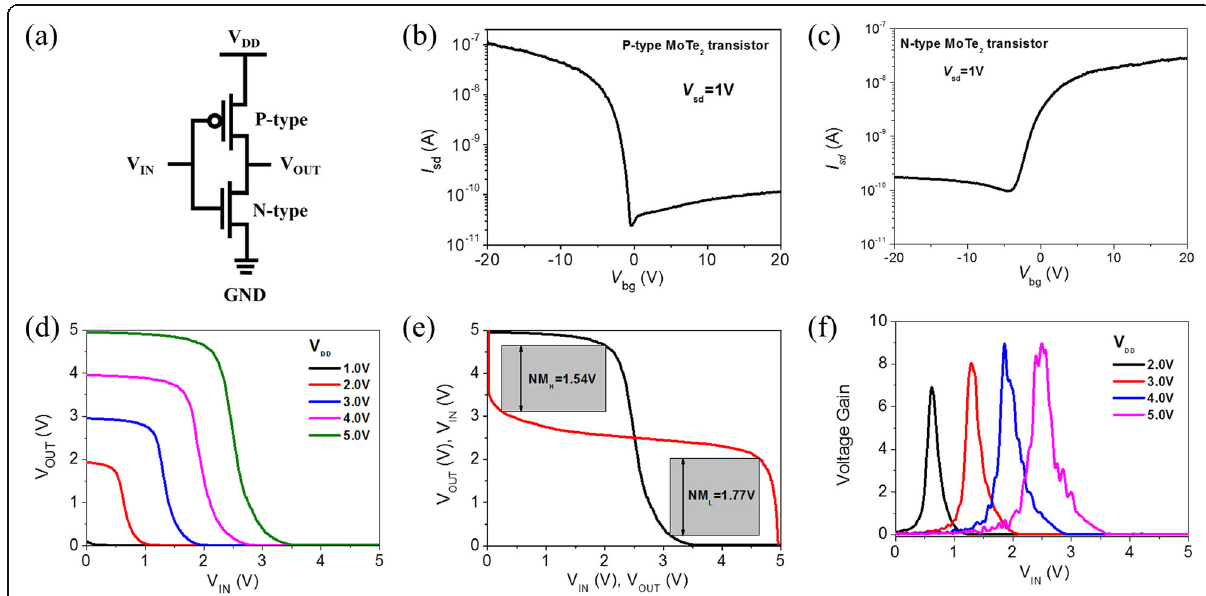
Fig. 9 Complementary inverter properties based on p-type and n-type multi-layered MoTe 2 transistor in 8 × 10 − 5 mbar vacuum. a Inverter diagram composed of p-type and n-type MoTe 2 transistors. Transfer characteristics of p-type ( b ) and n-type ( c ) MoTe 2 transistor from the inverter. d VTC curves of the inverter for V DD values varying from 1 to 5 V. e VTC curves (black lines) and their mirrors (red lines) at V DD = 5 V. f V IN - dependent voltage gains of the inverter at V DD = 2 V, 3 V, 4 V, and 5